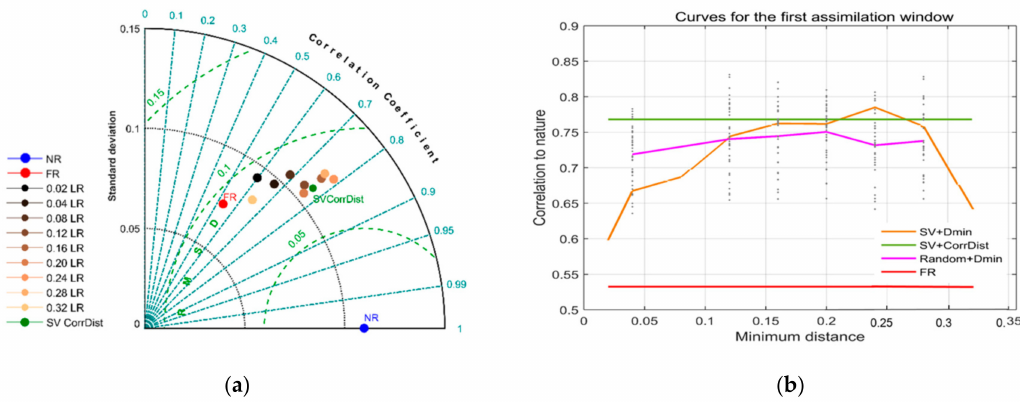
Figure 10. Representation in the Taylor diagram ( a ) and correlation graph ( b ) of the analyses obtained for the first assimilation window. Each case corresponds to a network configuration defined by the highest SVs and the minimum fixed distance, expressed as a fraction of the Rossby deformation radius. The green point and the green line correspond to the case of a variable distance based on the correlation map.